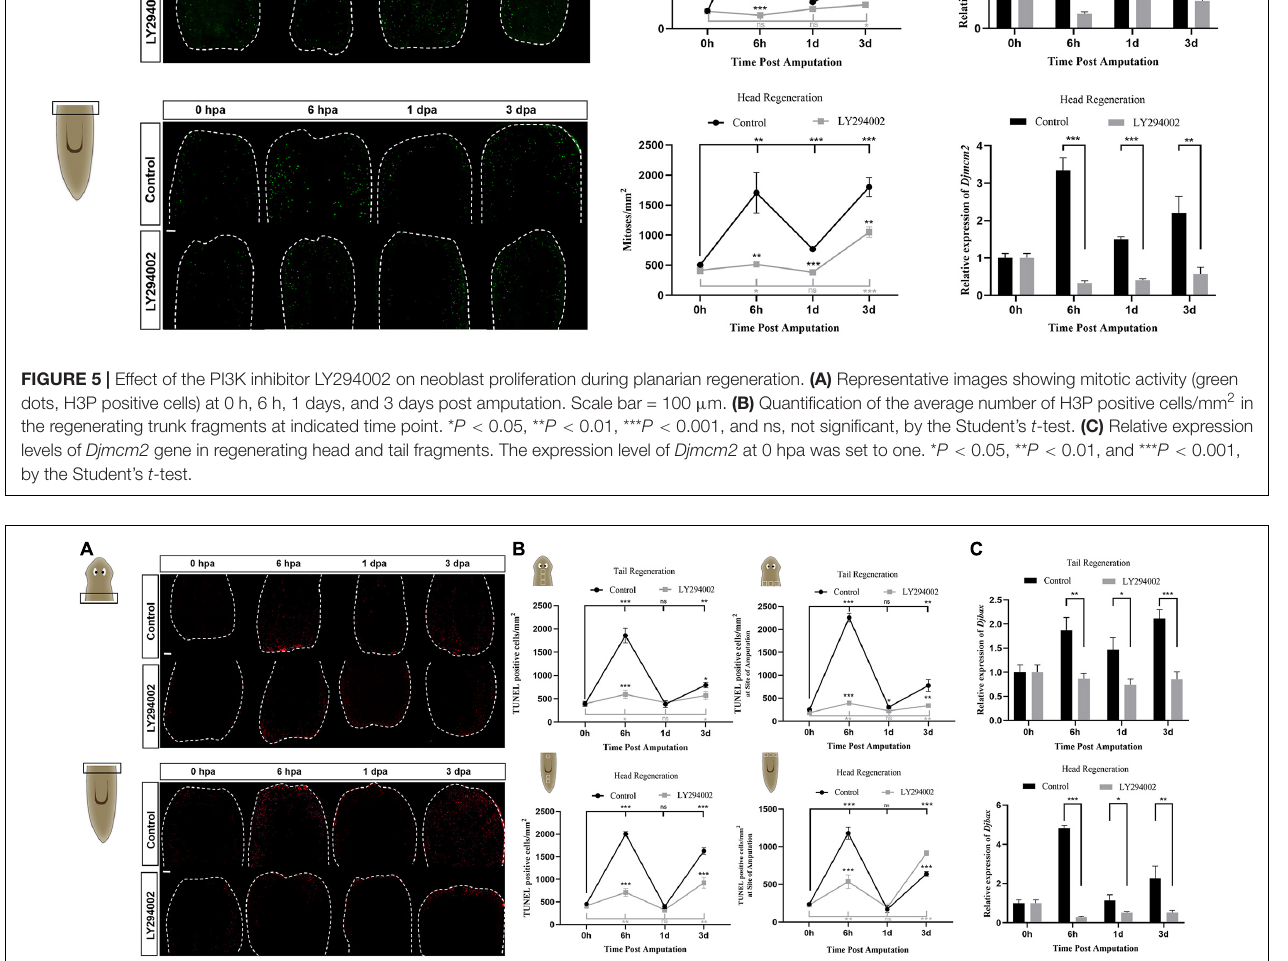
FIGURE 6 | Effect of the PI3K inhibitor LY294002 on apoptotic cell death during planarian regeneration. (A) Immunostaining of TUNEL-positive nuclei of trunk fragments at 0 h, 6 h, 1 days, and 3 days post amputation. Scale bar = 100 µ m. (B) Quantification of the average number of TUNEL-positive cells/mm 2 in the whole trunk fragments (left panel) or at the amputation sites (right). * P < 0.05, ** P < 0.01, *** P < 0.001, and ns, not significant, by the Student’s t -test. (C) Relative expression levels of Djbax gene in regenerating head and tail fragments. The expression level of Djbax at 0 hpa was set to one. * P < 0.05, ** P < 0.01, *** P < 0.001, and ns, not significant, by the Student’s t